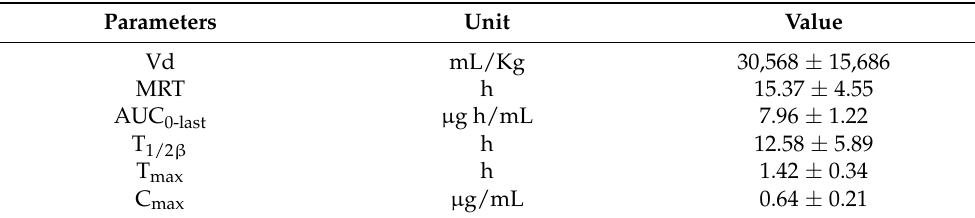
Table 2. Pharmacokinetic parameters for ENR-SD granules after oral administration in